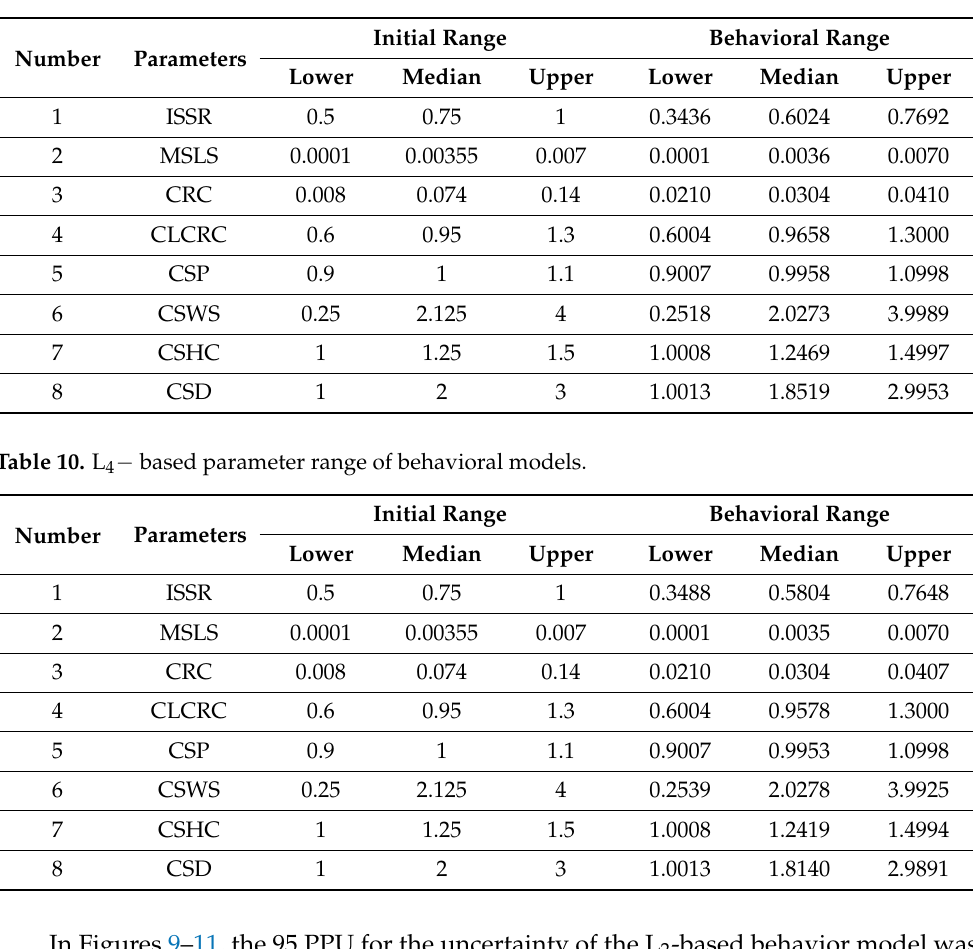
Table 9. L 3 − based parameter range of behavioral models.